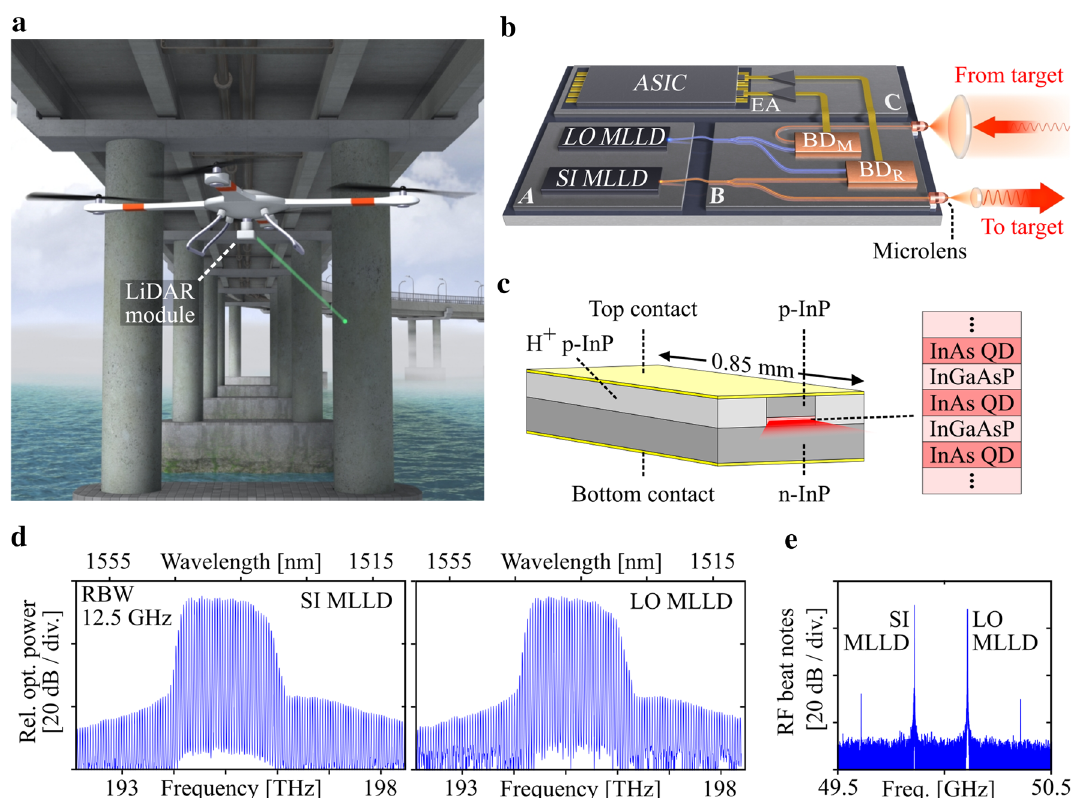
Figure 1. Application scenario and technical concept of an ultrafast chip-scale LiDAR system. ( a ) Compact lightweight LiDAR modules lend themselves to application in autonomously navigating carrier systems such as drones. High-resolution scanning of 3D surface profiles may complement 2D camera images for a reliable quantitative analysis of damage patterns, e.g., in structural health monitoring of large buildings or critical infrastructures. ( b ) Concept of a fully integrated dual-comb LiDAR system realized as a multi-chip assembly that combines a pair of MLLD-based frequency comb sources realized on InP substrates (A), silicon photonic transmitter and receiver circuits (B), and processing electronics (C) in a compact lightweight package. For distance measurements, light is emitted through a micro-lens directly attached to the chip, collimated by a macroscopic lens and directed towards the target via a beam scanner (not shown). The backscattered light is coupled back to the chip and sent to a balanced photodetector (BD M ) for multi-heterodyne reception. An electronic application-specific integrated circuit (ASIC) is used for digital signal processing and extraction of the distance information. ( c ) Schematic of the QD-MLLD. The active medium comprises a stack of three InAs QD layers separated by InGaAsP layers. The pump current is applied via the bottom and top contact. The cavity is formed by the cleaved end facets of the chip with roughly 30% reflectivity each. Due to the inhomogeneously broadened gain spectrum of the QD material, multiple longitudinal lasing modes can oscillate simultaneously in the laser cavity, mode-locked by self-induced carrier density modulations. This leads to a time-periodic optical signal with a comb-like spectrum, where the FSR is determined by the roundtrip-time and hence the length of the cavity. ( d ) Left: Emission spectrum of the MLLD used as signal comb (SI MLLD), having an FSR of 49.72 GHz. Right: Emission spectrum of MLLD used as local oscillator (LO MLLD), for which the FSR amounts to 50.21 GHz. e RF beat notes of both MLLDs. The narrow RF linewidth of the order of 10 kHz indicates stable mode-locking of neighboring optical tones. The noise floor in this measurement is limited by the effective number of bits (ENOB ≈ 5) of the high-speed oscilloscopes (Keysight UXR0804A) that were used to digitize the signals, see Supplementary Information, Section ‘Noise impairments of recorded signals’ for a more detailed In contrast to other comb generators, QD-MLLDs emit frequency combs by simply applying a DC current 13,14 , without the need for high-speed RF devices 6,8,21 or fiber-based amplifiers 7,9 . Typically, QD-MLLDs offer around 50 comb lines with FSR in the range of 10 GHz to 100 GHz. In our devices, the total comb power amounts to 20 mW with an average line power of 400 µW. The simple operation of QD-MLLDs and their relatively large power per comb line along with the potential for hybrid or monolithic integration with photonic integrated circuits make the devices attractive for chip-scale LiDAR systems.